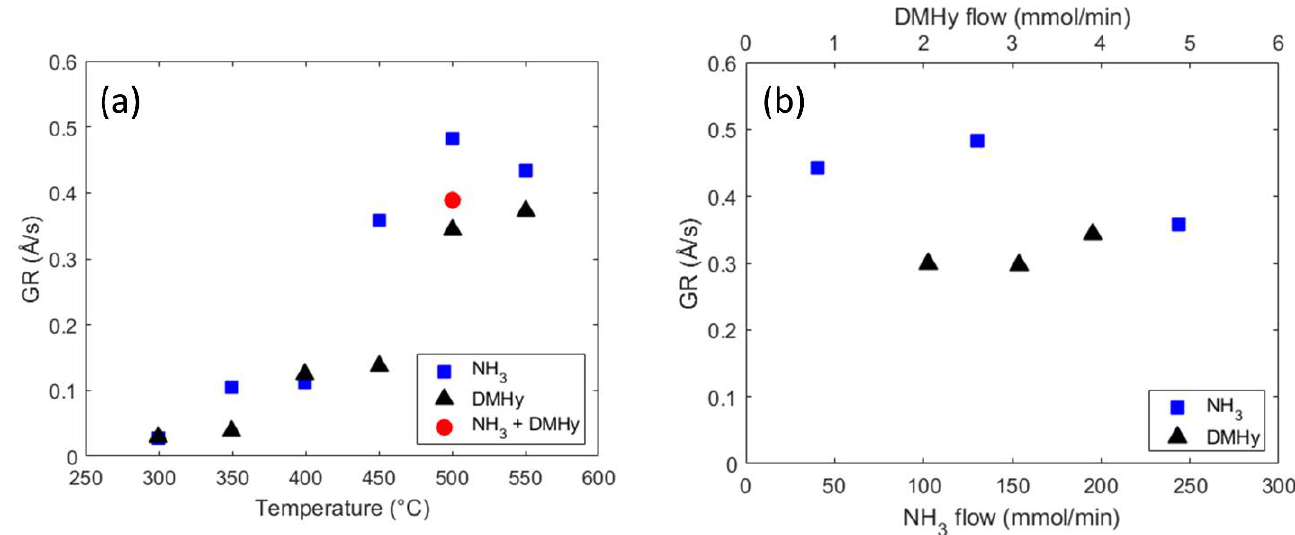
Figure 1. GR calibrations for GaN grown with TEGa (10.5 μmol/min) and either NH 3 , DMHy, or both precursors. ( a ) GR versus temperature for 143 mmol/min NH 3 , 3.9 mmol/min DMHy, and one data point for 143 mmol/min NH 3 + 3.9 mmol/min DMHy. ( b ) GR versus N-precursor flow at 500 °C with the DMHy flow given on the top x -axis.